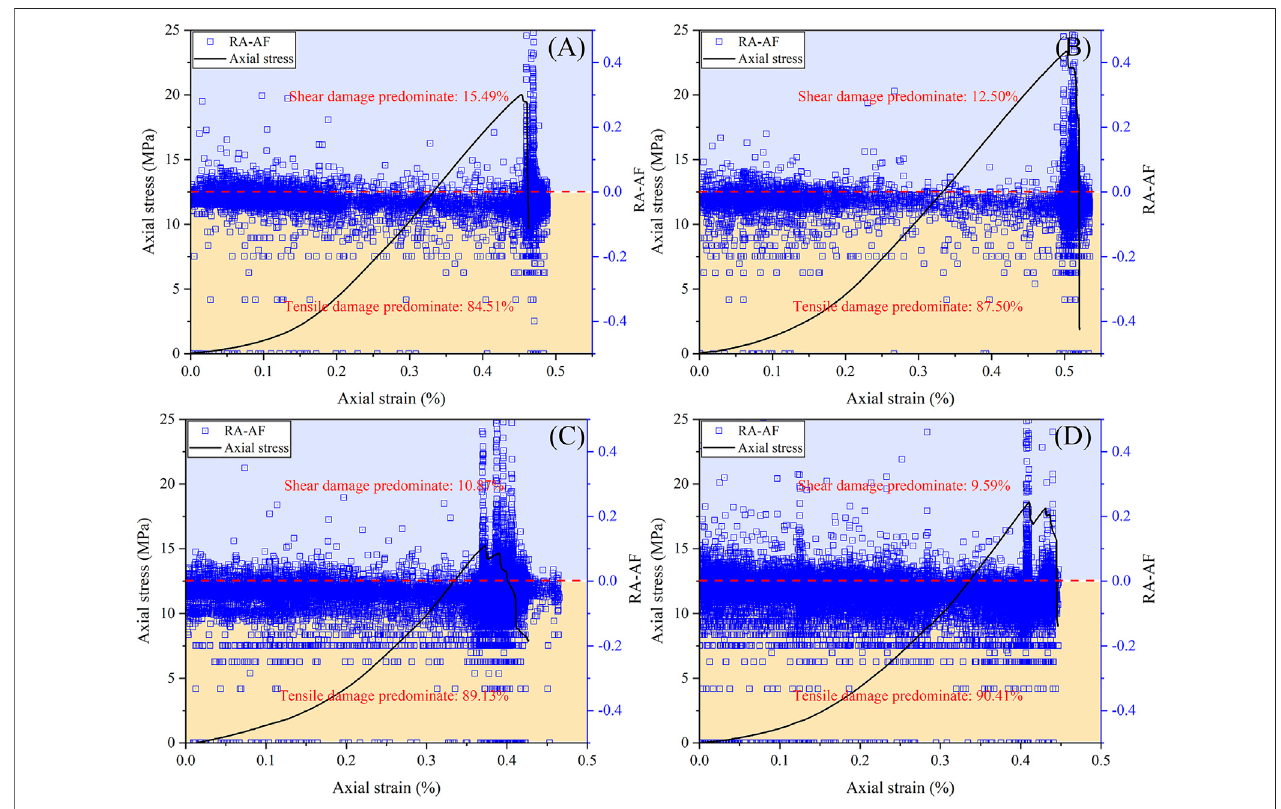
FIGURE 7 | AE FA-AF of jointed and bolted jointed specimens under uniaxial compression: (A) 75 ° jointed specimen, (B) 75 ° bolted jointed specimen, (C) 45 ° jointed specimen, and (D) 45 ° bolted jointed specimen.